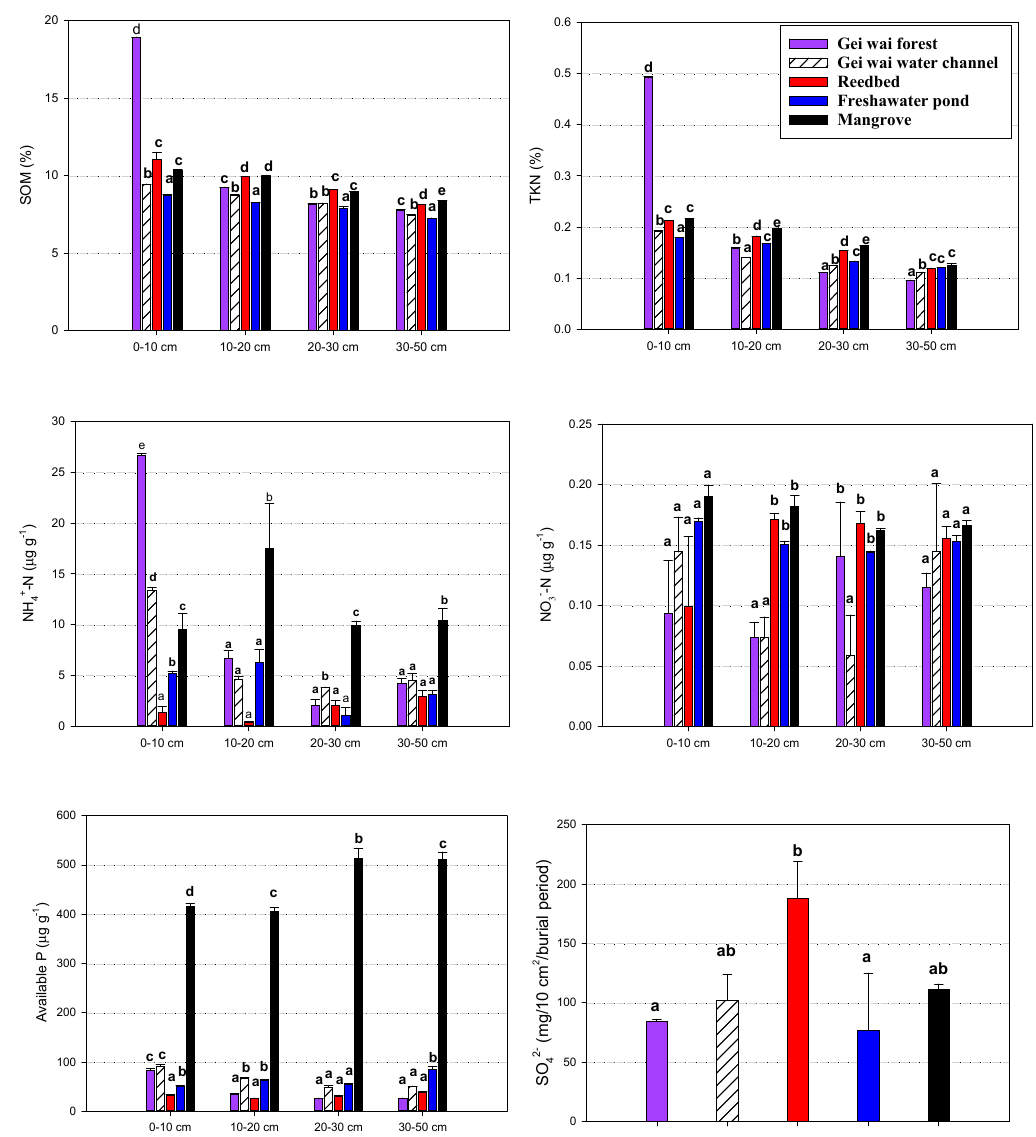
Figure 5. Mean SOM, TKN, NH 4+ -N, NO 3 − _ N, available P concentrations and sulfate supply rate at different soil depths for the five land use types. Data are means ± standard deviation. Different letters represent significant differences in nutrient concentration among the land use types at a given depth ( p < 0.05 ).